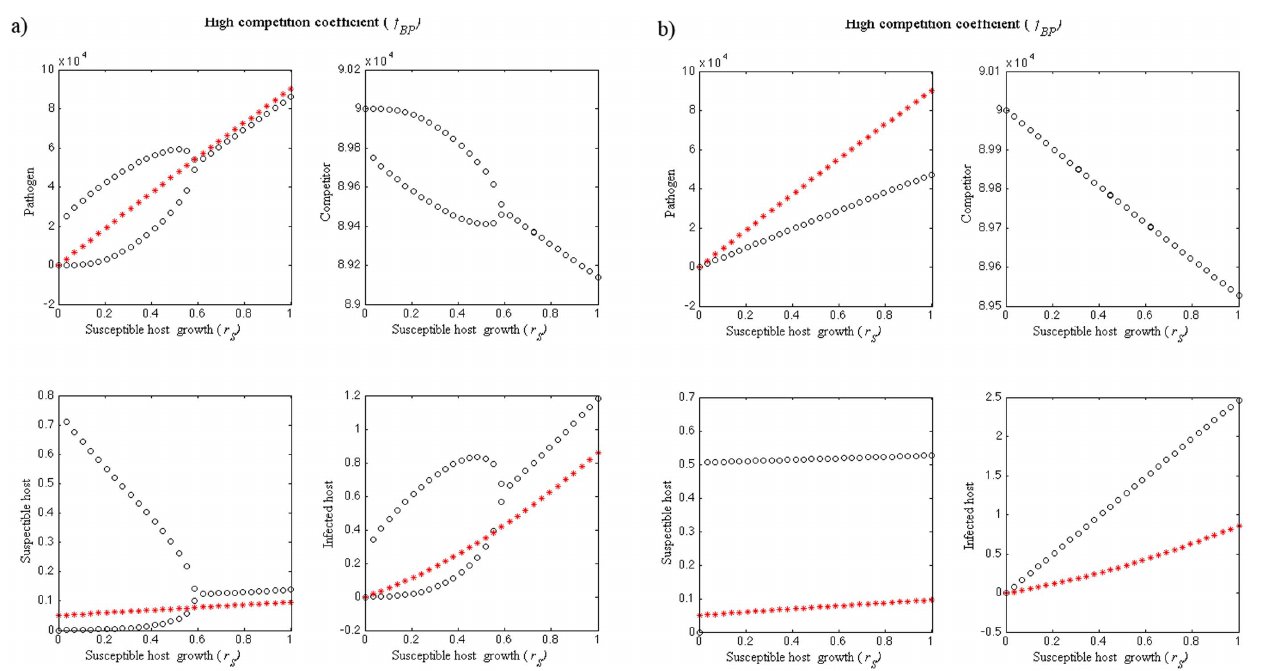
Figure 3. Bifurcation figures of the S-I-P-B dynamics, presenting maximum and minimum values (black circles), as well as equilibrium densities when competitor ( B ) is not present (red stars) of susceptible host ( S ), pathogen ( P ) and non-pathogenic ( B ) population densities in different combinations of susceptible host growth rate of pathogen ( r S ) parameter values ( r S 5 0–1). In all the figures f PB 5 10 2 7 . a) When outside-host growth rate of pathogen ( r P ) is 0.05 and the competition coefficient ( f BP ) is 10 2 5 , decreasing r S destabilizes the disease dynamics. b) When r P is (0.05) and f BP is higher (10 2 4 ), pathogen population is able to increase and the dynamics are locally stable and all four populations coexist.